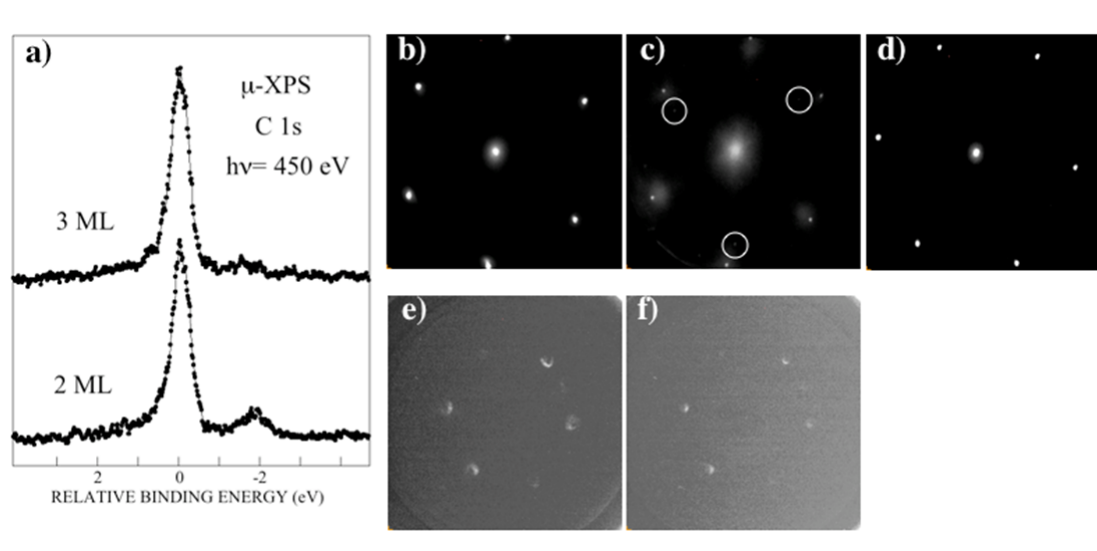
Figure 4. ( a ) C 1s spectra collected, using a probing area of 4 μ m, from domains